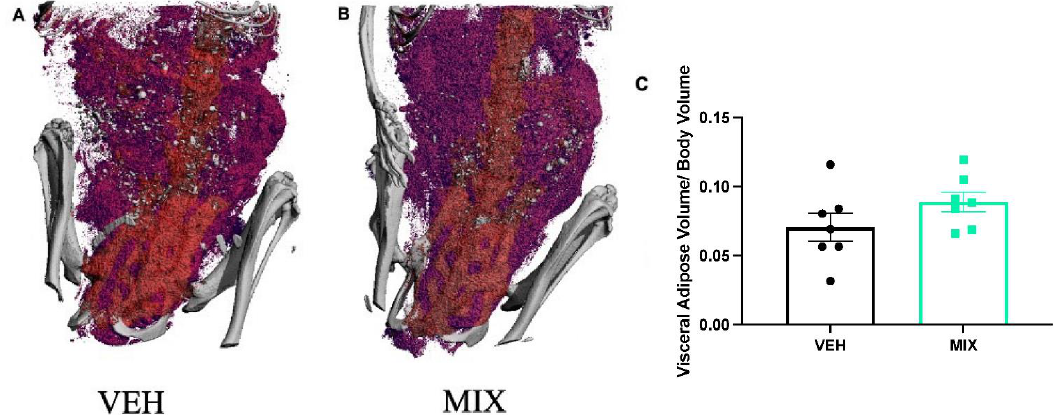
Figure 3. Pregnant Dams Visceral Adipose Visualization. Six months following the cessation of exposure, MIX and vehicle dams underwent a CT scan for visceral adipose assessment. ( A ) A representative image of the vehicle dams. ( B ) A representative image of the MIX dams. ( C ) MIX dams had a non-significant ratio of visceral adipose volume to body volume compared to vehicle dams. Data are shown as mean ± standard error ( n = 7/group, p = 0.08).